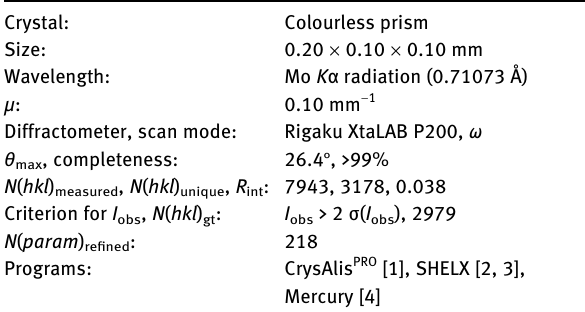
Table  : Data collection and